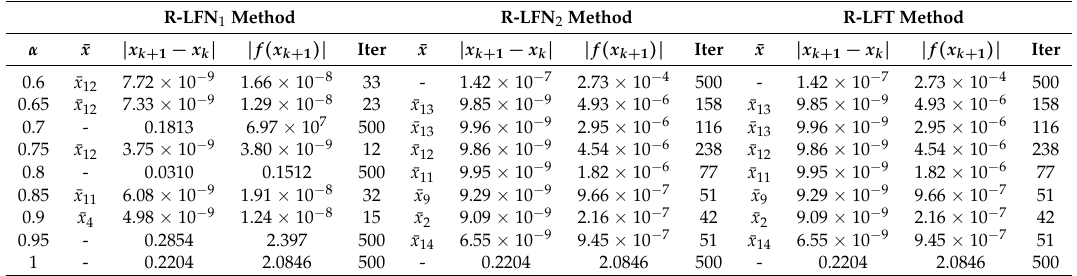
Table 7. Fractional Newton 1 and Newton 2 results for f 3 ( x ) with Riemann–Liouville derivative and initial estimation x 0 = 3.